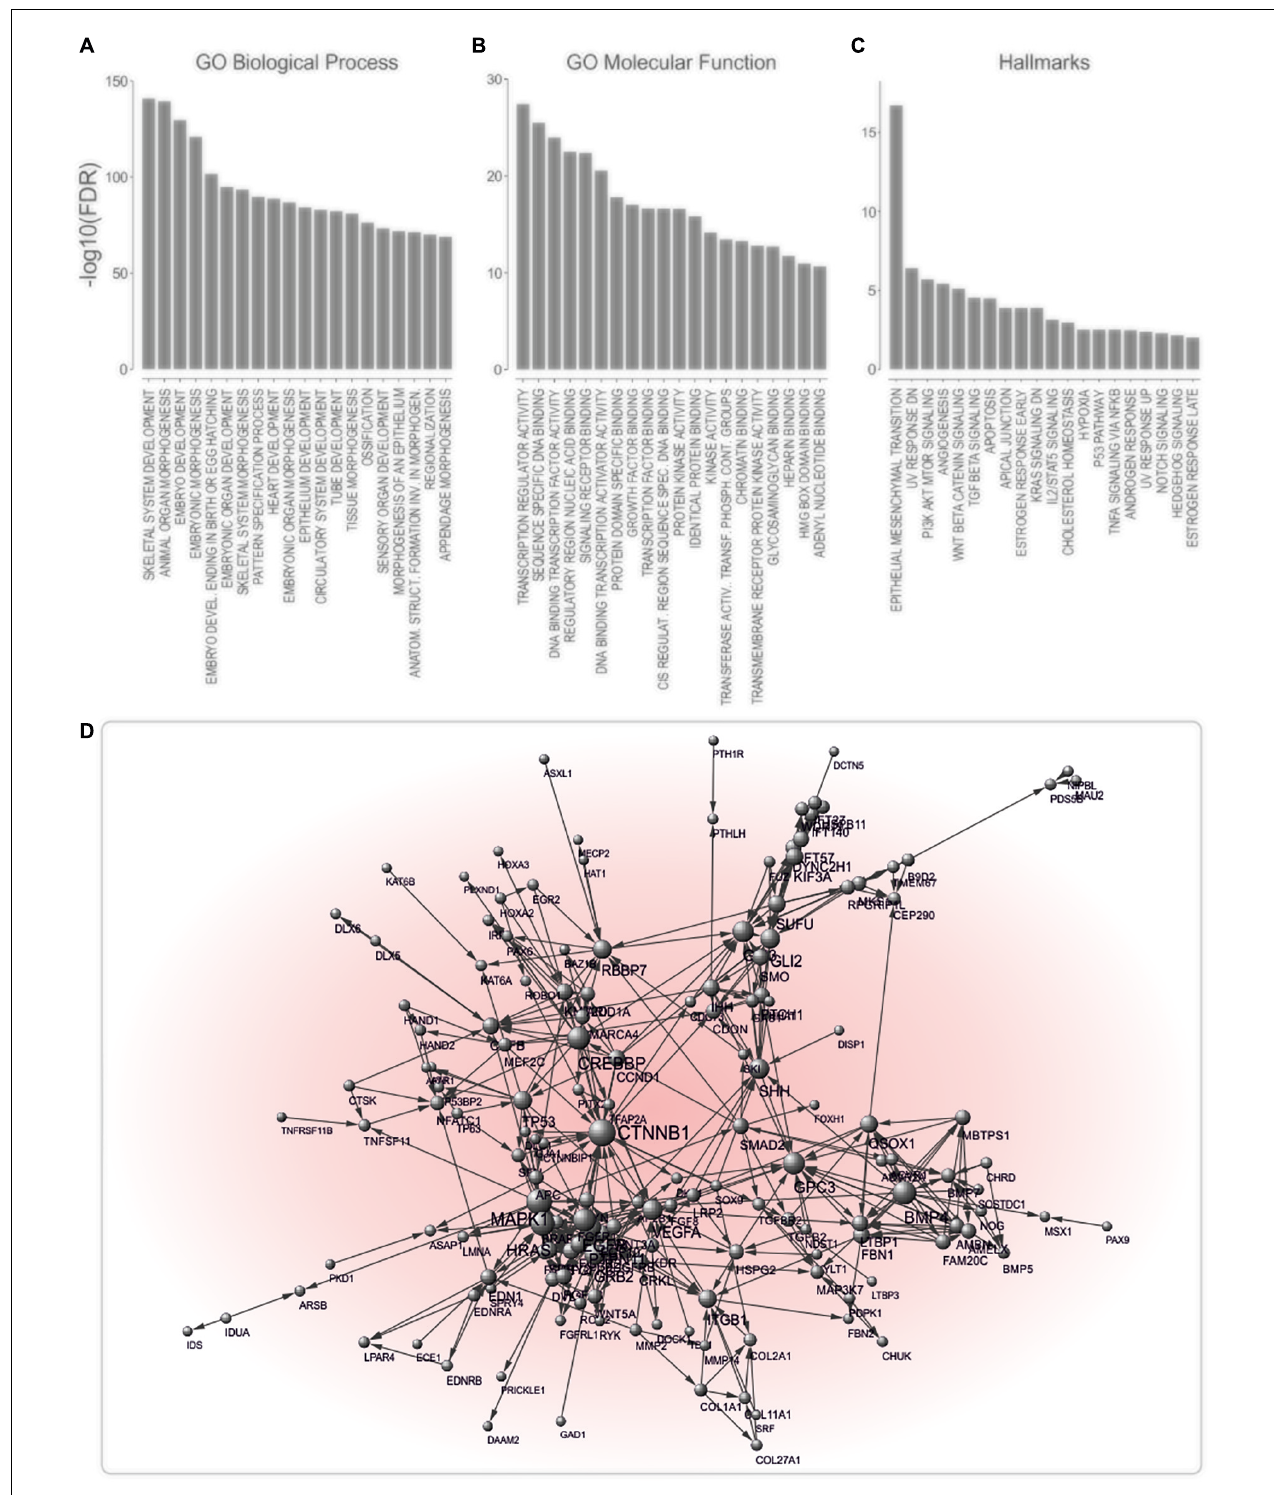
FIGURE 3 | JIGs exhibit a high degree of interconnectedness. (A–C) Analysis of enriched GO biological processes: (A) GO molecular functions, (B) and hallmark processes, (C) indicates a role of JIGs in the development and EMT, mainly via affecting transcriptional regulation. (D) Interaction network of JIGs (interaction confidence score ≥ 0.9) shows that 173 of 305 genes/proteins are highly interconnected. The nodes represent genes/proteins and the connecting edges functional associations. Node sizes reflect node degree.